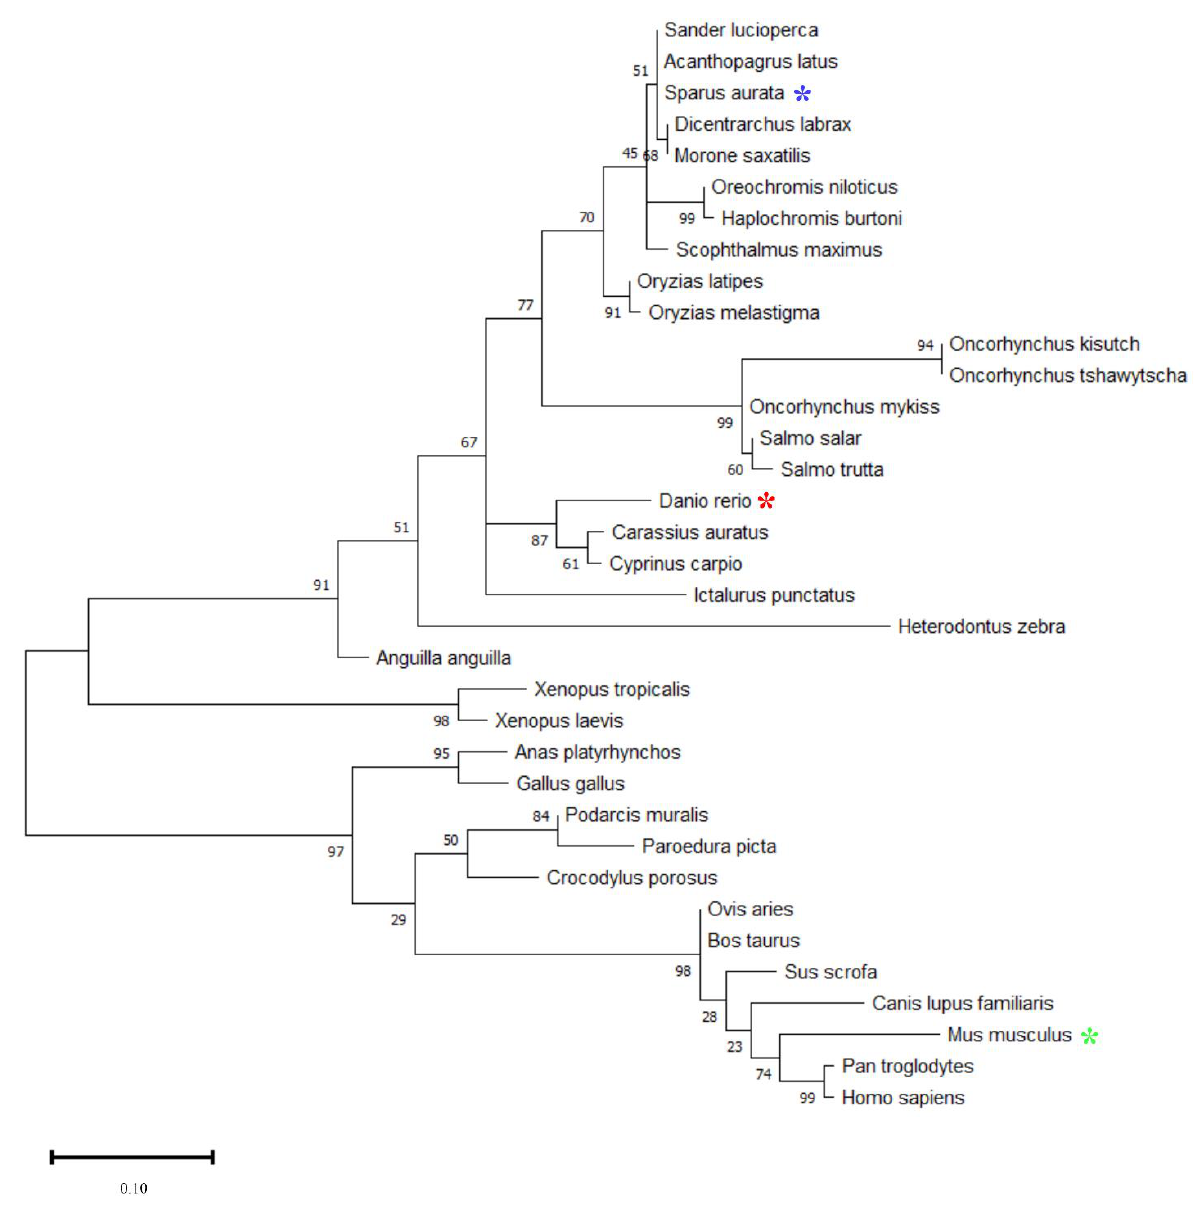
Figure 3. Phylogenetic analysis of Myomixer protein in mammals, birds, reptiles, amphibians, and fish. Multiple alignment of whole protein sequences was done through the MAFFT tool (https://mafft.cbrc.jp/alignment/server/, accessed on 12 February 2020) with the progressive G-INS-1 method. The phylogenetic tree was developed with the Maximum Likelihood phylogeny and the JTT+G substitution model using the MEGA 11 v11.0.1.10 program. The numbers in the tree nodes represent the percentage of the bootstrap values after 500 replications. The study species ( Sparus aurata ), as well as the model species Danio rerio and Mus musculus are marked with blue, red and green asterisks.